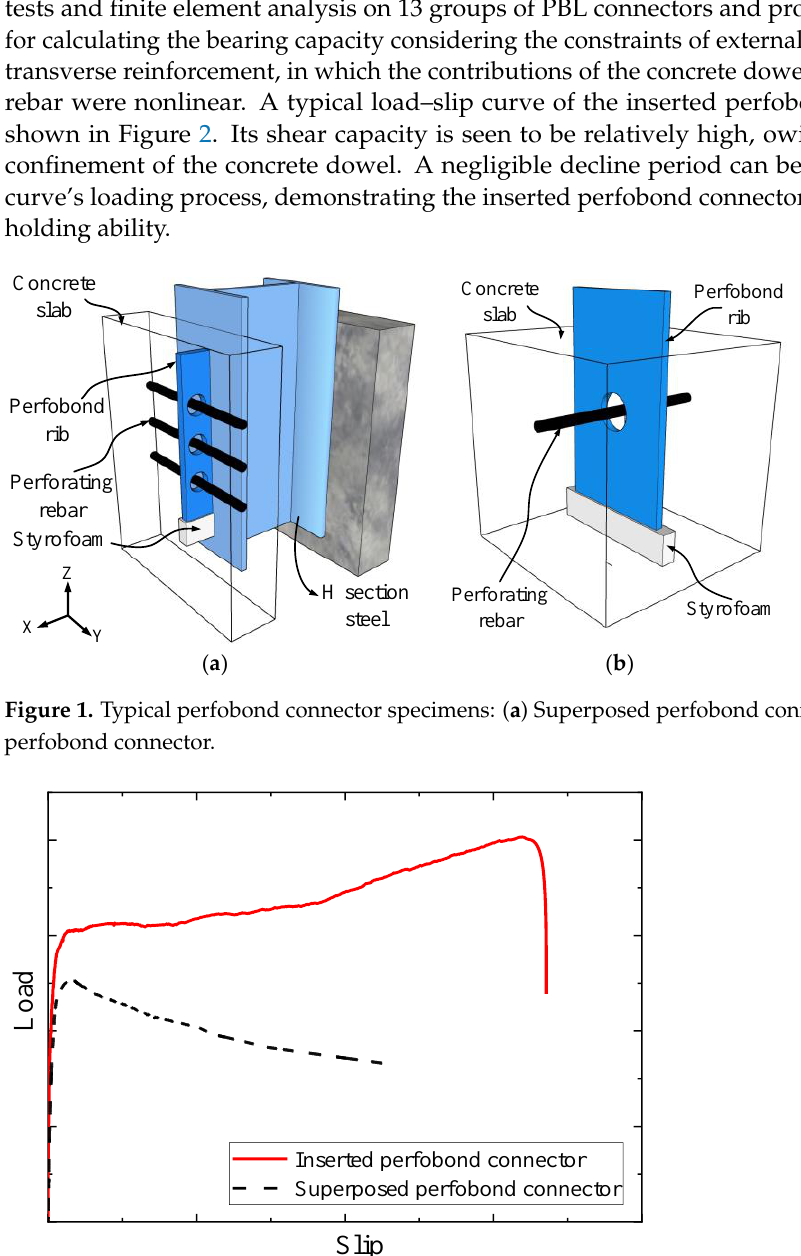
Figure 2. Typical load – slip curves of two connector types.